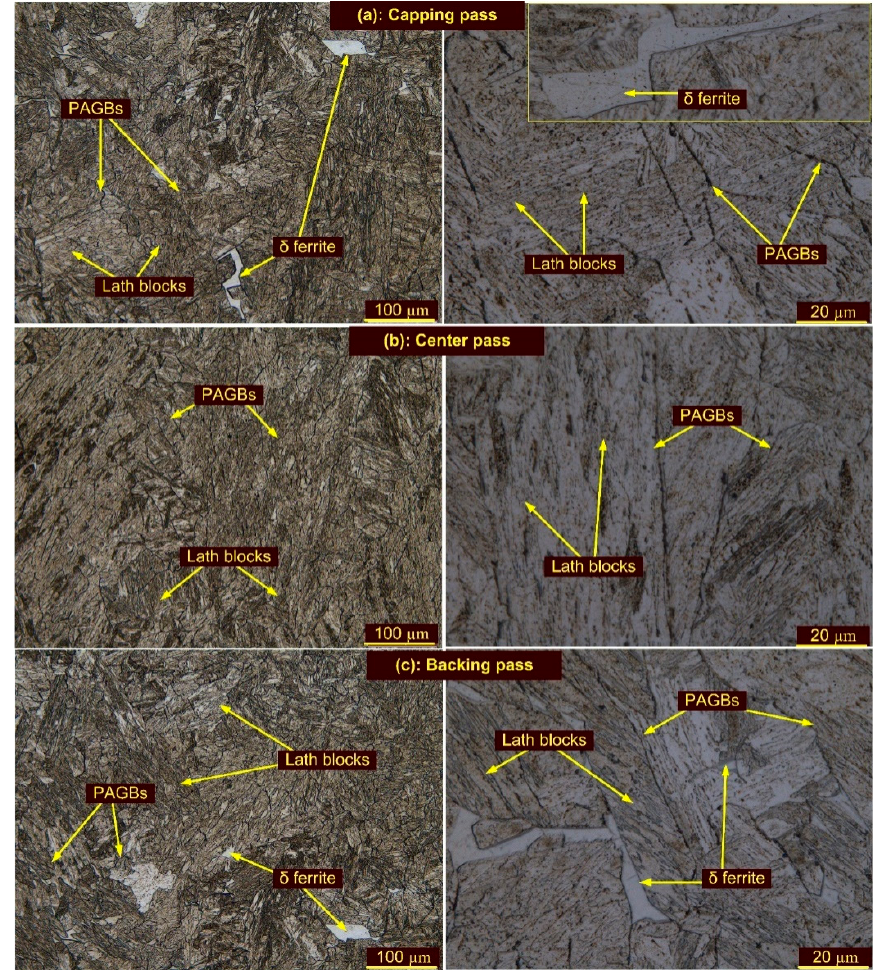
Figure 7. Optical image of WFZ corresponding to passes: ( a ) capping pass, ( b ) center pass, ( c ) backing pass.